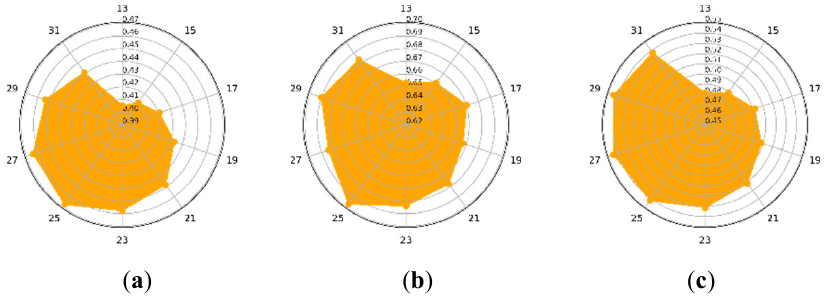
Figure 9. The impact of β on the proposed CLAP. ( a ) Indian Pines dataset. ( b ) Pavia University dataset. ( c ) WHU-Hi-HongHu dataset.